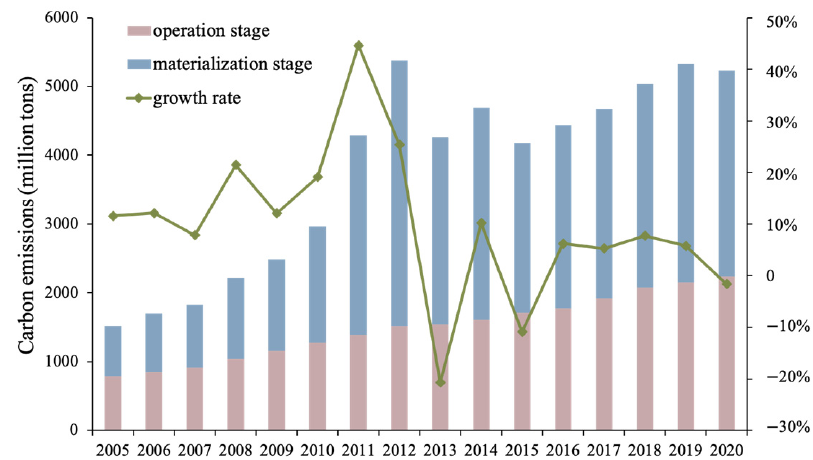
Figure 1. China’s CEBS from 2005 to 2020. Figure 2 reflects the spatial distribution of CEBS in 2005, 2010, 2015, and 2020. With a gradual increase from the west to the east, the building sector’s carbon emissions in the eastern coastal area are typically greater than those in the western region, and the difference in carbon emissions between regions has further expanded over time. The provinces with the highest building carbon emissions in 2020 are Jiangsu (443.73 million tons) and Zhejiang (438.98 million tons), while the provinces with the lowest building carbon emissions are Hainan (16.13 million tons), Qinghai (17.48 million tons), and Ningxia (17.89 million tons), with large differences between provinces. In terms of growth rate, the provinces with the highest growth rates of building carbon emissions from 2005 to 2020 were Fujian, Jiangxi, and Sichuan, with growth rates of 615.16%, 563.16%, and 464.85%, respectively.